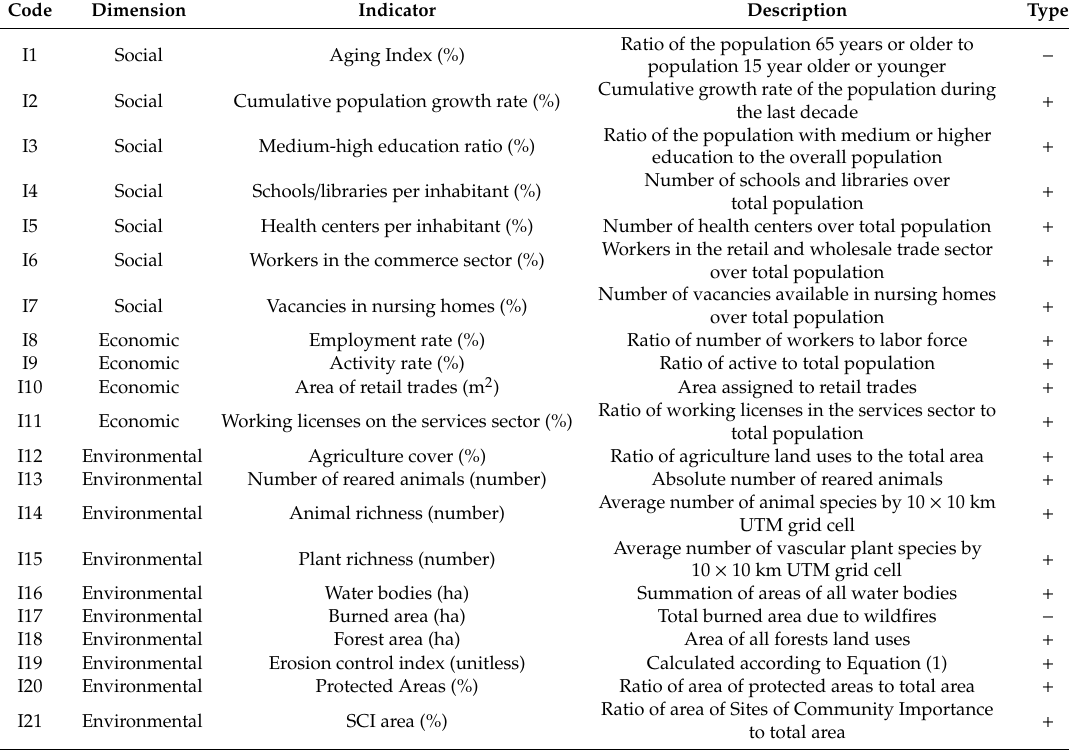
Table 1. Description of indicators used for comarcas in the Huesca province by dimension and type. Code Indicator